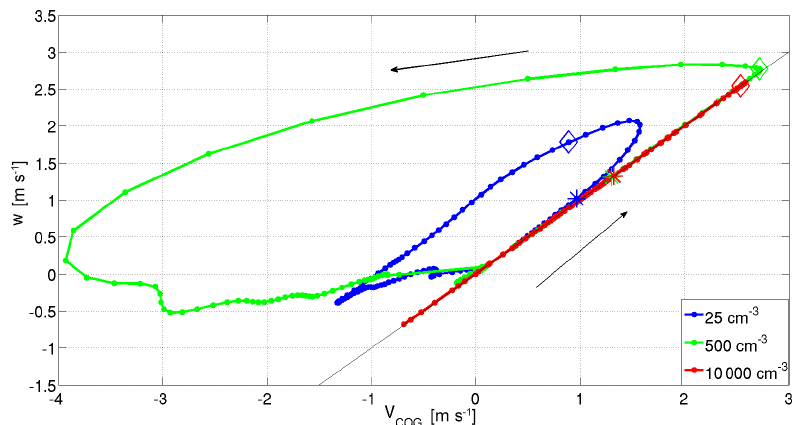
Figure 2. Cloud evolution on the phase space span by w vs. V COG . The arrows mark the direction of the trajectories and the thin black line is the 1:1 line. Stars and diamonds denote t = 40min and 55min of the simulation,